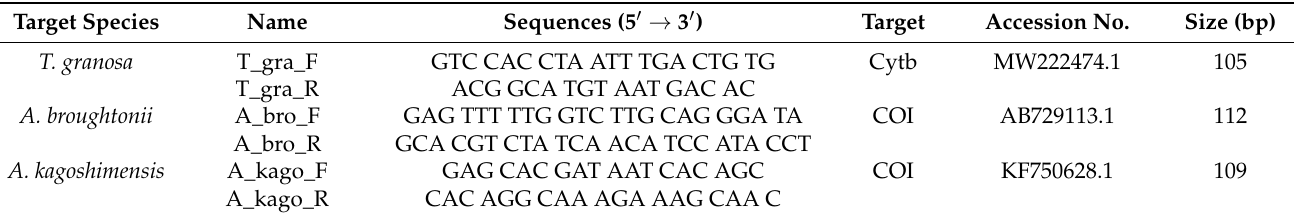
Table 1. The information on primer sets developed in this